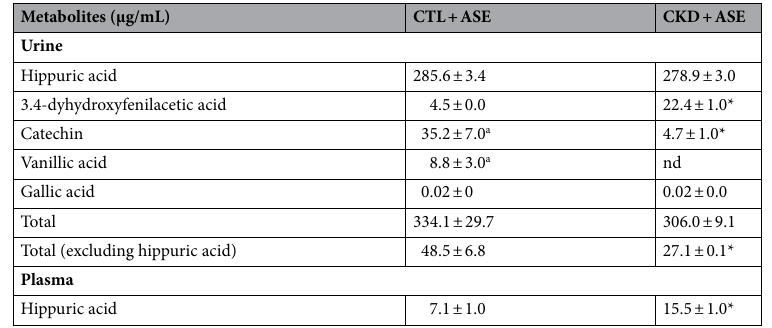
Table 3. Metabolites of phenolic compounds in plasma and urine of experimental mice. Data are expressed as mean ± SD (n = 4 for each group). Significant differences were determined by Mann & Whitney U tests. nd Not detected, CKD Chronic kidney disease, ASE Açaí seed extract. *Indicates a significant difference at the P < 0.05 level between